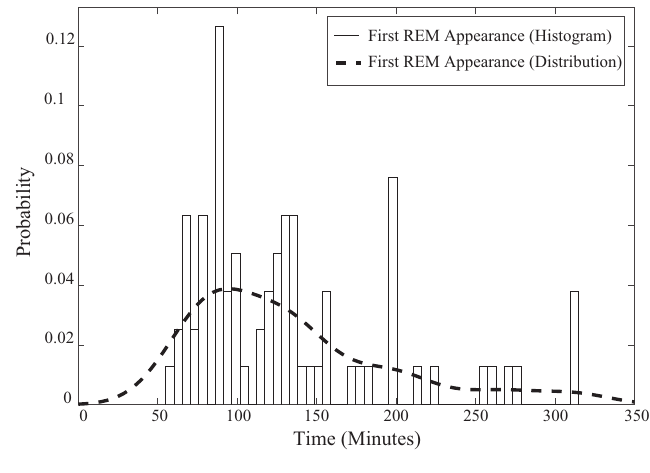
Figure 5. First occurrence of